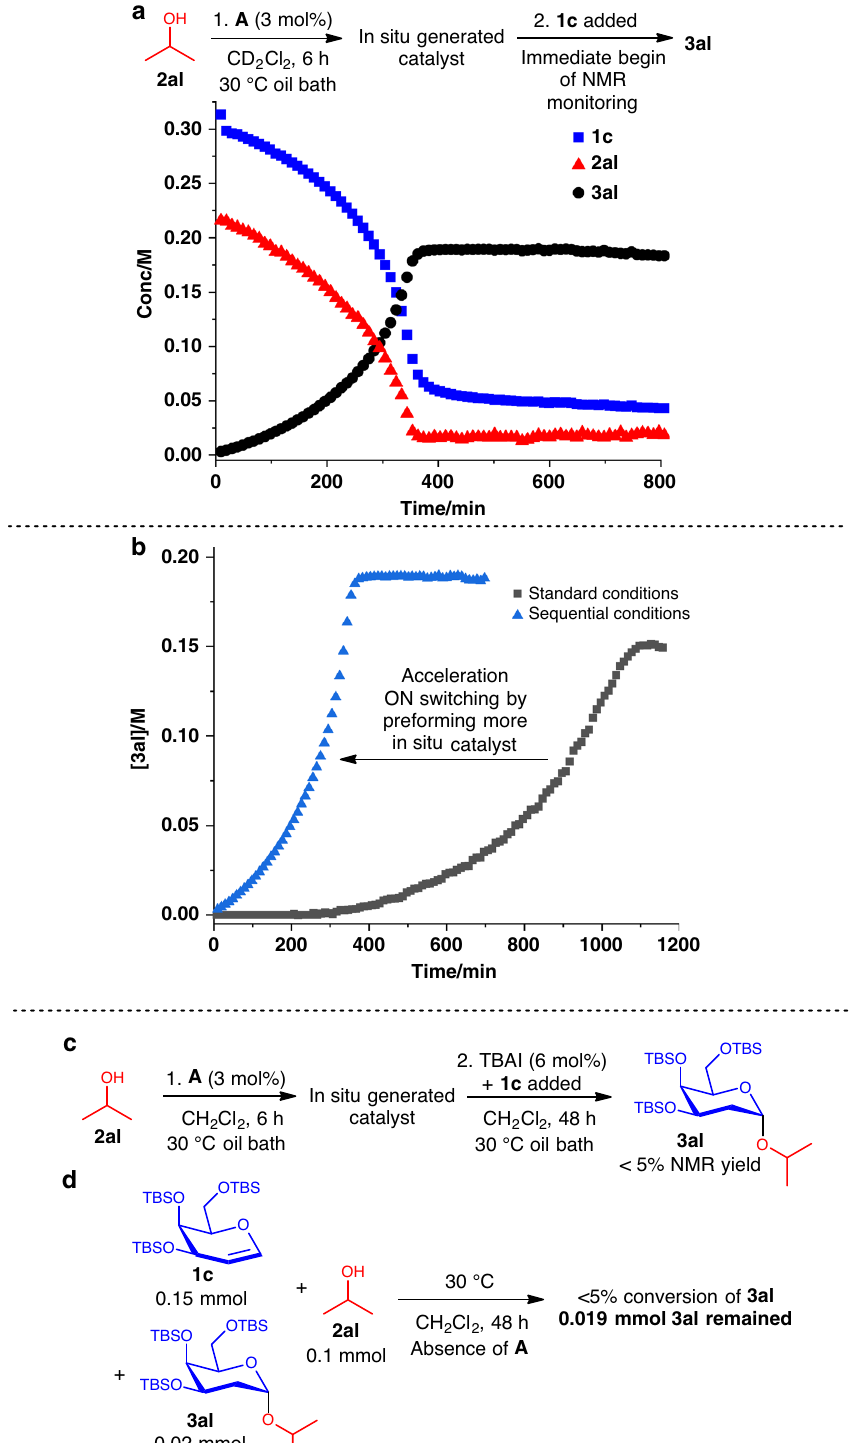
Fig. 7 Sequential and control experiments. a Sequential kinetic experiment unraveled enhanced acceleration of product formation. b Comparison of 3al formation kinetics of standard vs sequential conditions. c Poisoning using TBAI to ascertain XB in fl uence on the in situ catalyst. d Control experiment to support the absence of persistently accelerating kinetic behavior also corroborates that the amount of in situ active catalyst present during the entire experiment is signi fi cantly lower than the 3 mol% of A added at the onset. This acceleration is analogous to an ON switching of the catalytic network.